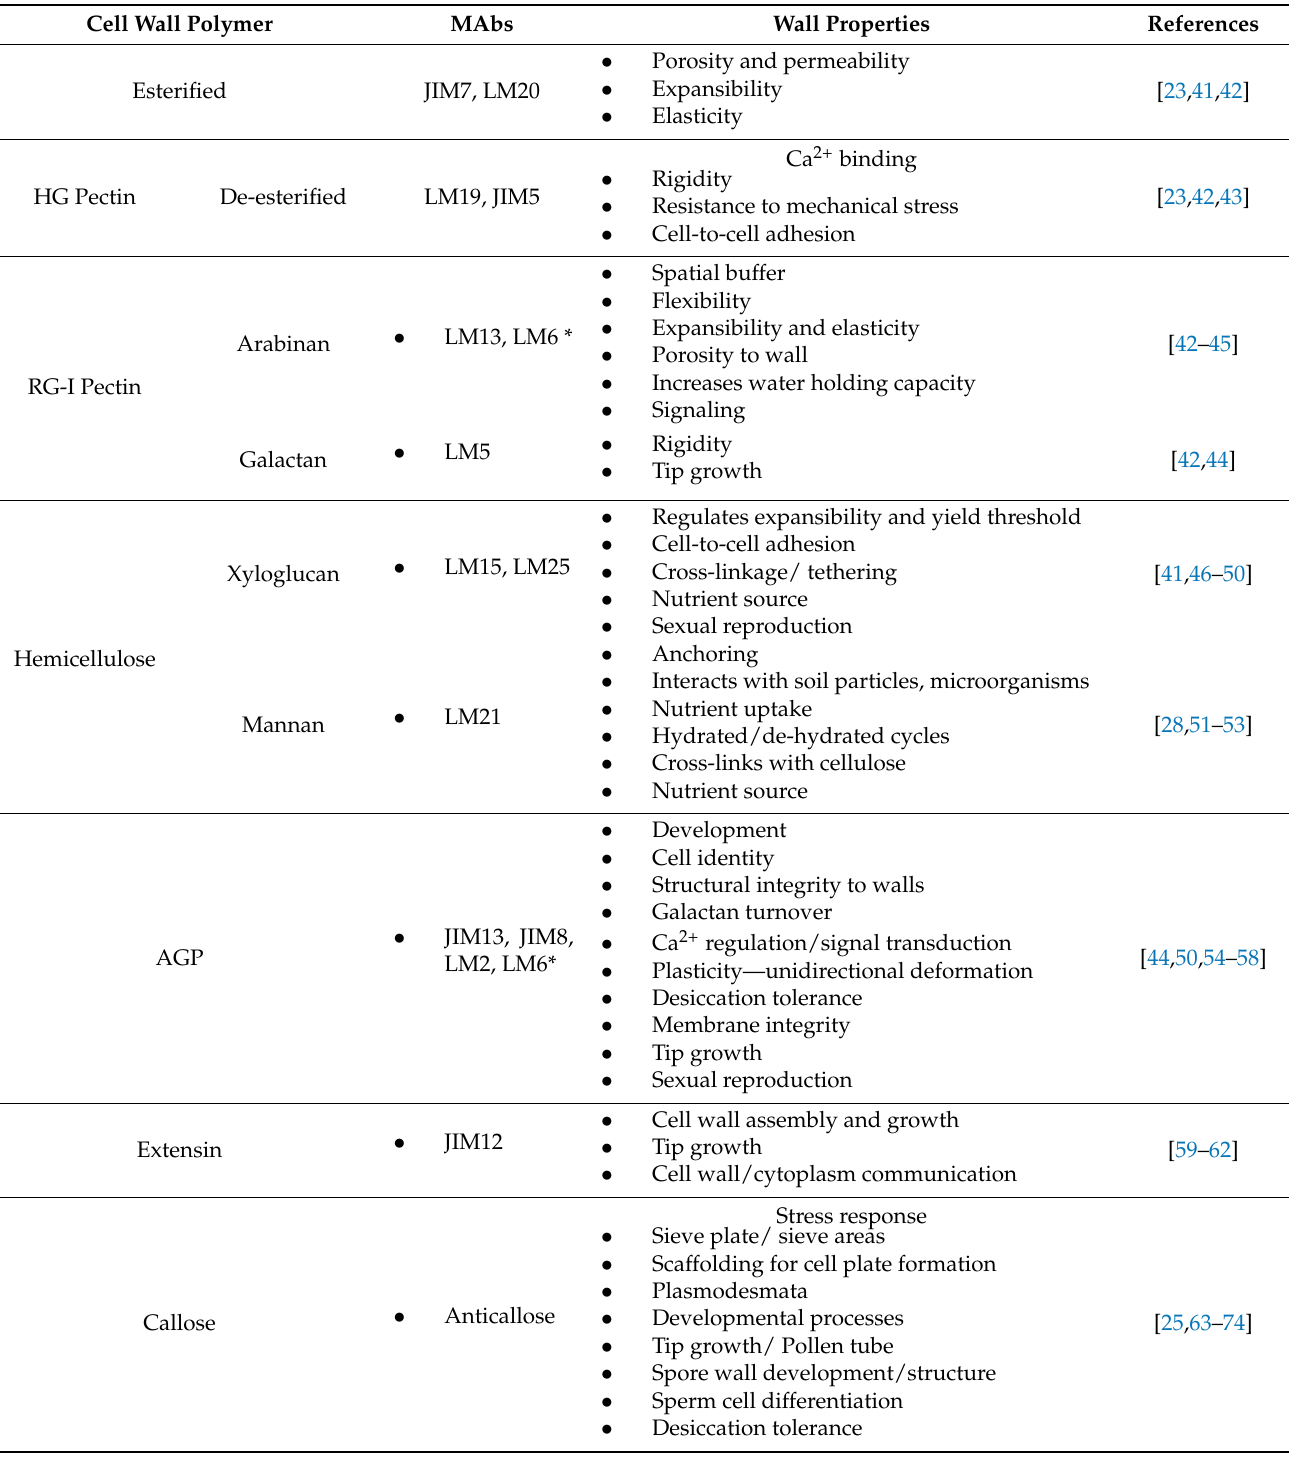
Table 3. Cell wall polymers, the MAbs that target them, their reported properties, and the supporting references. * LM6 detects arabinan sidechains in both AGPs and